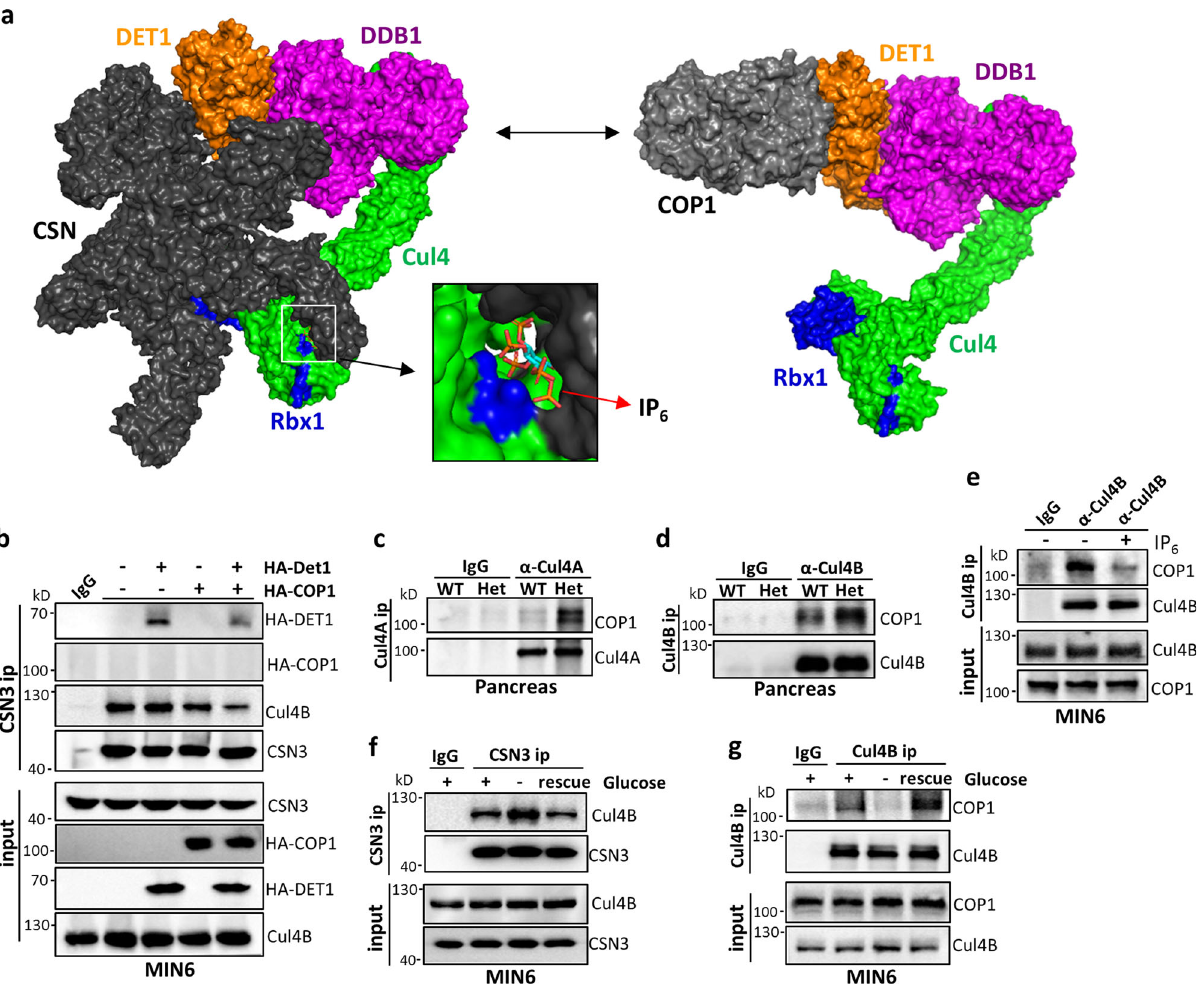
Fig. 4 COP1 outcompetes CSN to assemble the CRL4 COP1 E3 ligase for ETV5 degradation in Csn2 WT/K70E (Het) mice and in response to nutrients. a Structural models illustrating steric incompatibility between COP1 and CSN. For modeling details, see “ Methods ” . b Effect of COP1 and DET1 overexpression, individually or combined, on CRL – CSN complex formation in MIN6 cells. c , d CRL4 – COP1 complex formation detected by COP1 co- immunoprecipitation with Cul4A ( c ) and Cul4B ( d ) from WT and Csn2 WT/K70E pancreas lysates. e Effect of adding IP 6 (20 μ M) into MIN6 cell lysates on CRL4B COP1 complex formation. f Glucose fasting (2 h) increases CSN3-Cul4B co-ip in MIN6 cells, which is reversed by replacement with glucose-pro fi